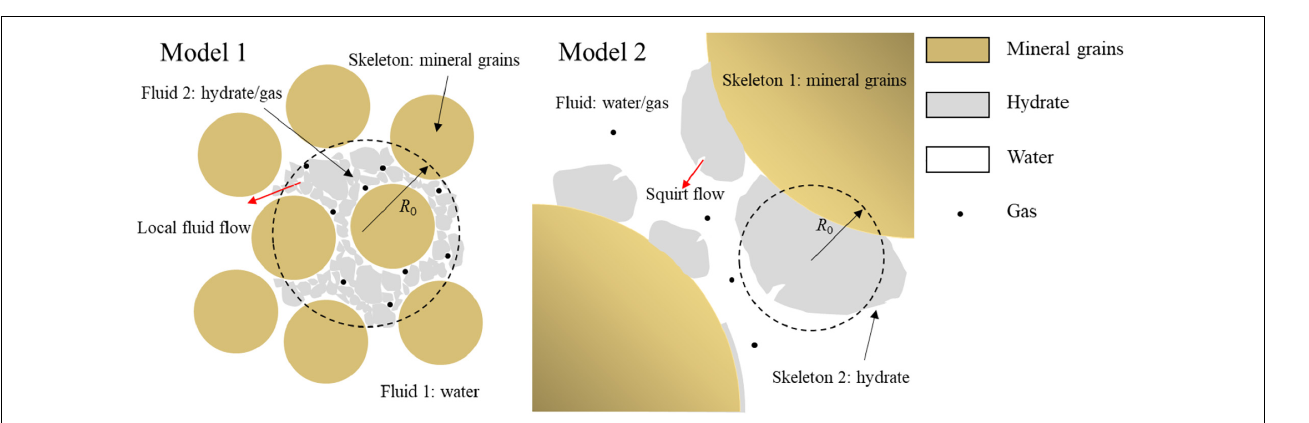
FIGURE 4 | The two models used in the workflow with the definition of the inclusion